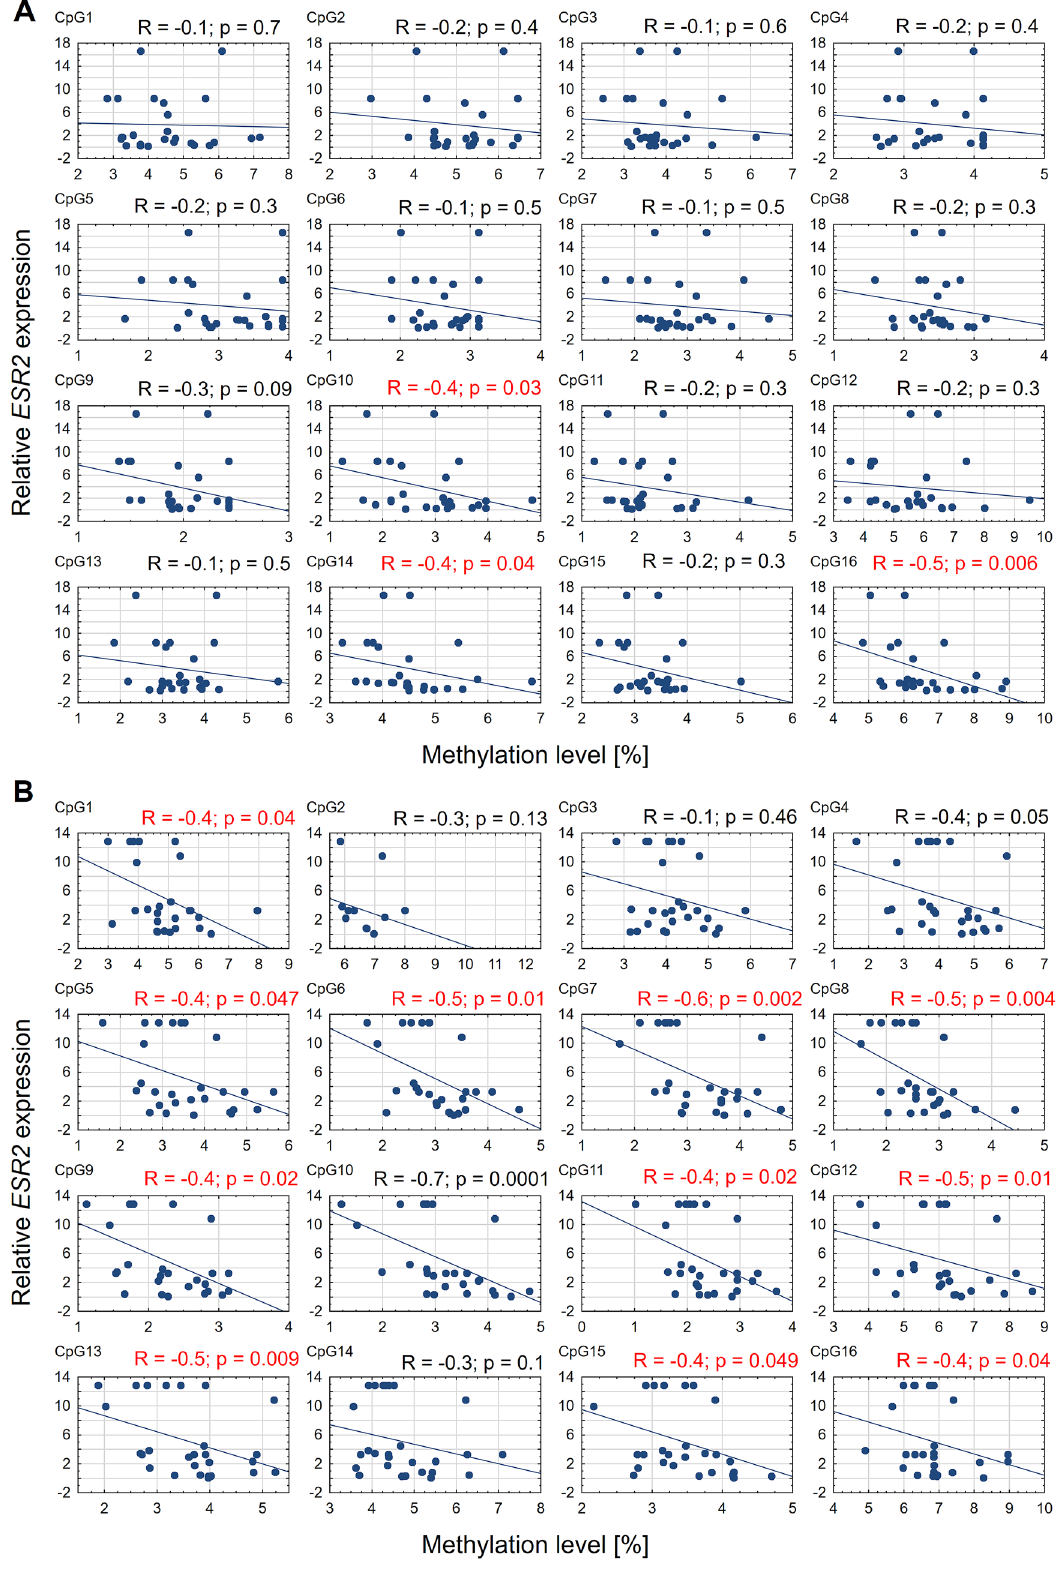
Figure 4. Correlation between ESR2 expression and methylation level at each CpG site in promoter 0N on the convex ( A ) and concave ( B ) side of the